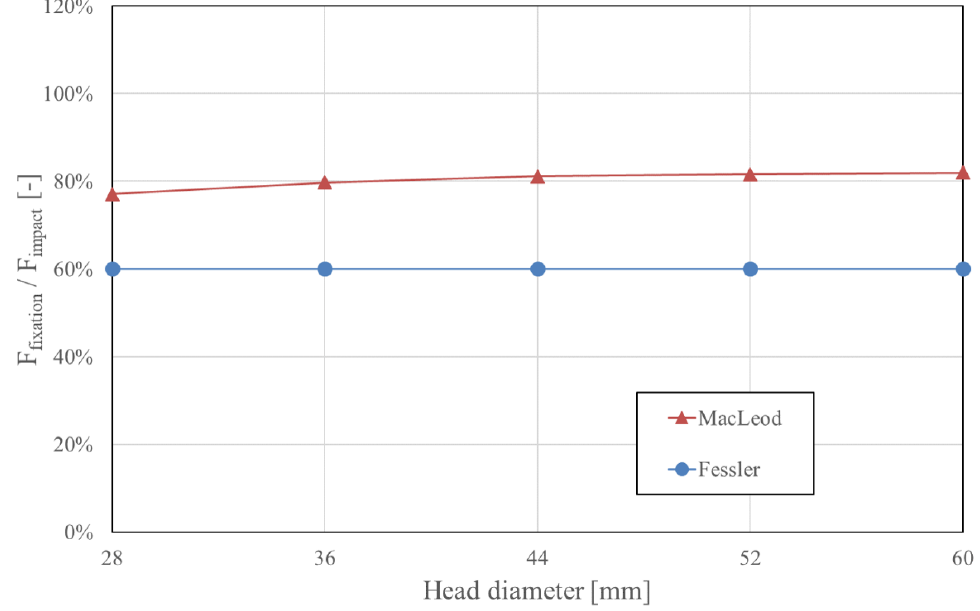
Figure 3. Influence of the diameter of the head on fixation force, as estimated by Fessler and MacLeod’s models. As this parameter is not considered in Fessler’s model, only MacLeod’s model shows a variability depending on this factor. The influence on fixation force, however, remains relatively small and negligible. Notably, MacLeod’s formula provides results with a positive influence for an increasing head size, whereas the measurements describe a decrease of approximately 20% in the fixation force when the head size is increased from 28 to 36 mm. With the impaction force having a linear e ff ect in both models, the fixation force is represented as a proportion of the impaction